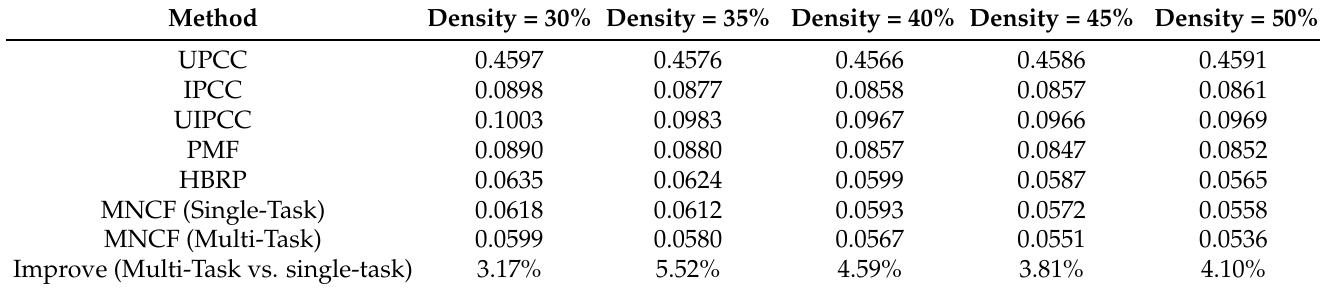
Table 2. Performance Comparison of RMSE of Prediction Models (MaxBlockBack = 100, MaxRTT = 5000).